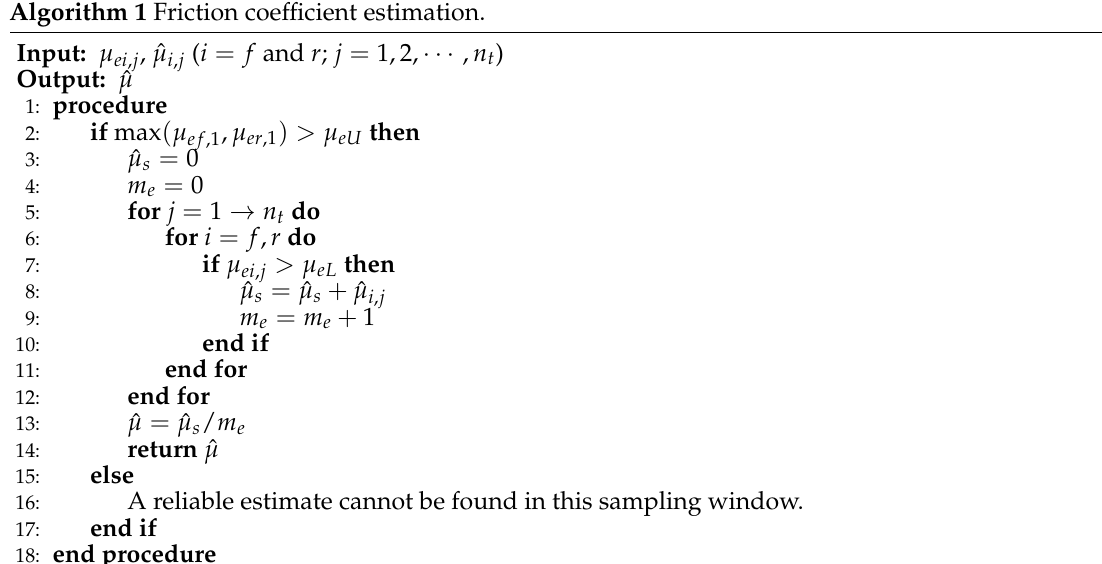
Algorithm 1 Friction coefficient